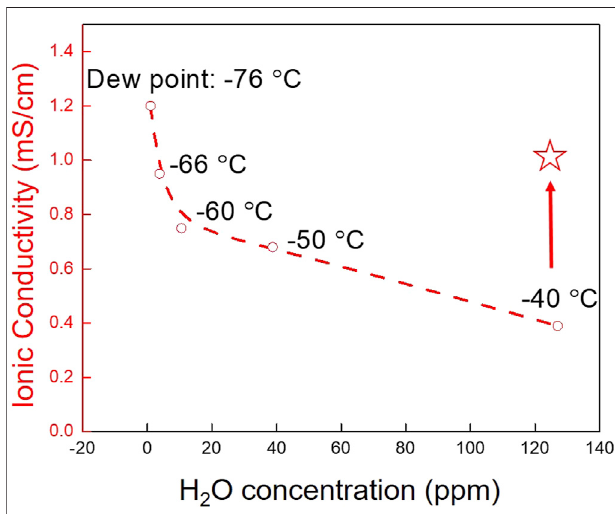
FIGURE8| IonicconductivityofLPSIsul fi deSSEafterexposureasadry powder to different dry room environments for 30 min. The star marks the